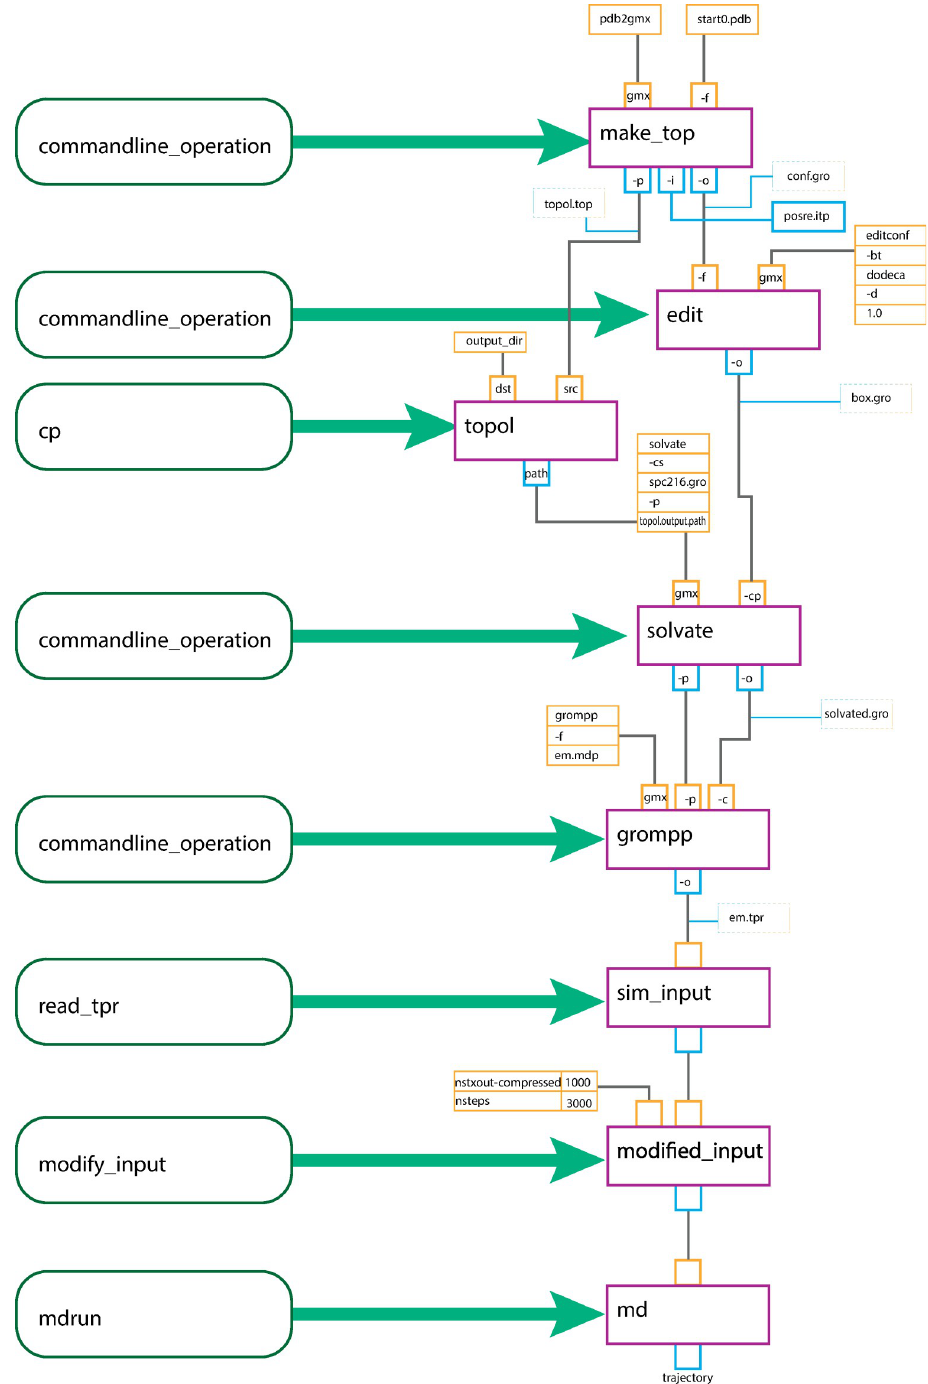
Fig 4. Detailed diagram of inputs, outputs, and operations in a chain of gmxapi operations. Operations are shown in green boxes, the corresponding nodes in the work graph in red boxes, inputs in orange boxes, and outputs in blue boxes. The diagram depicts a chain of GROMACS tools preparing simulation input, feeding into "gmxapi.mdrun" to run a batch of simulations.